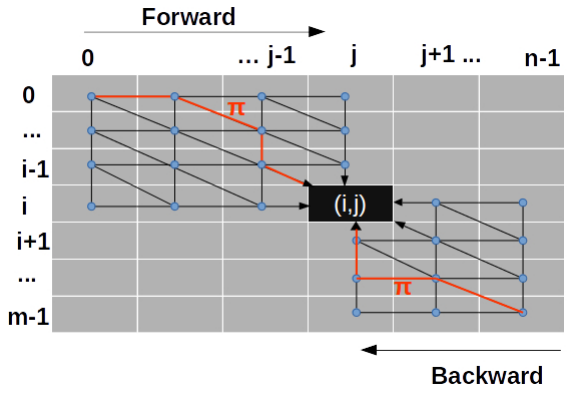
Figure 4. The forward–backward alignment kernel